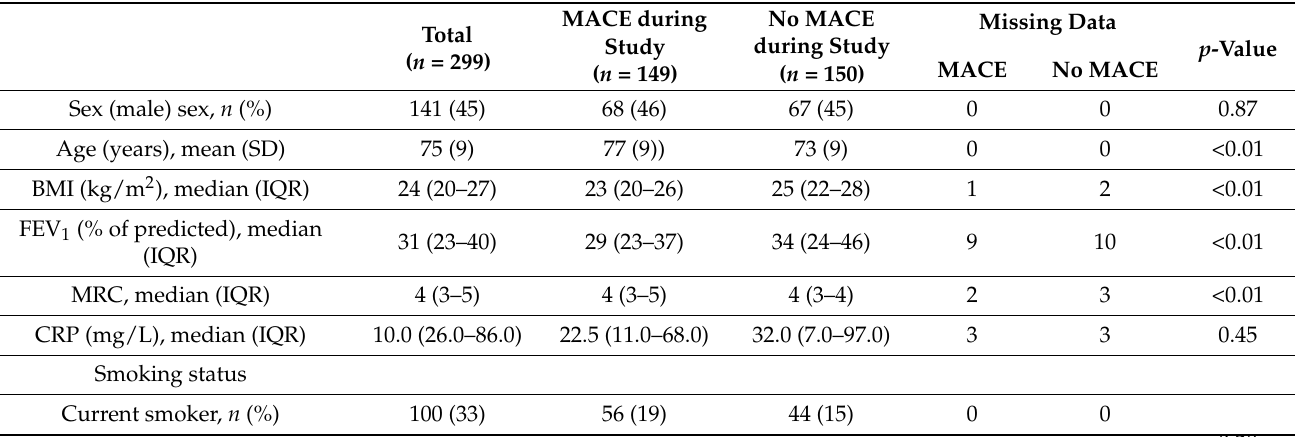
Table 1. Baseline characteristics. MACE: Major cardiovascular event, n : Number, SD: